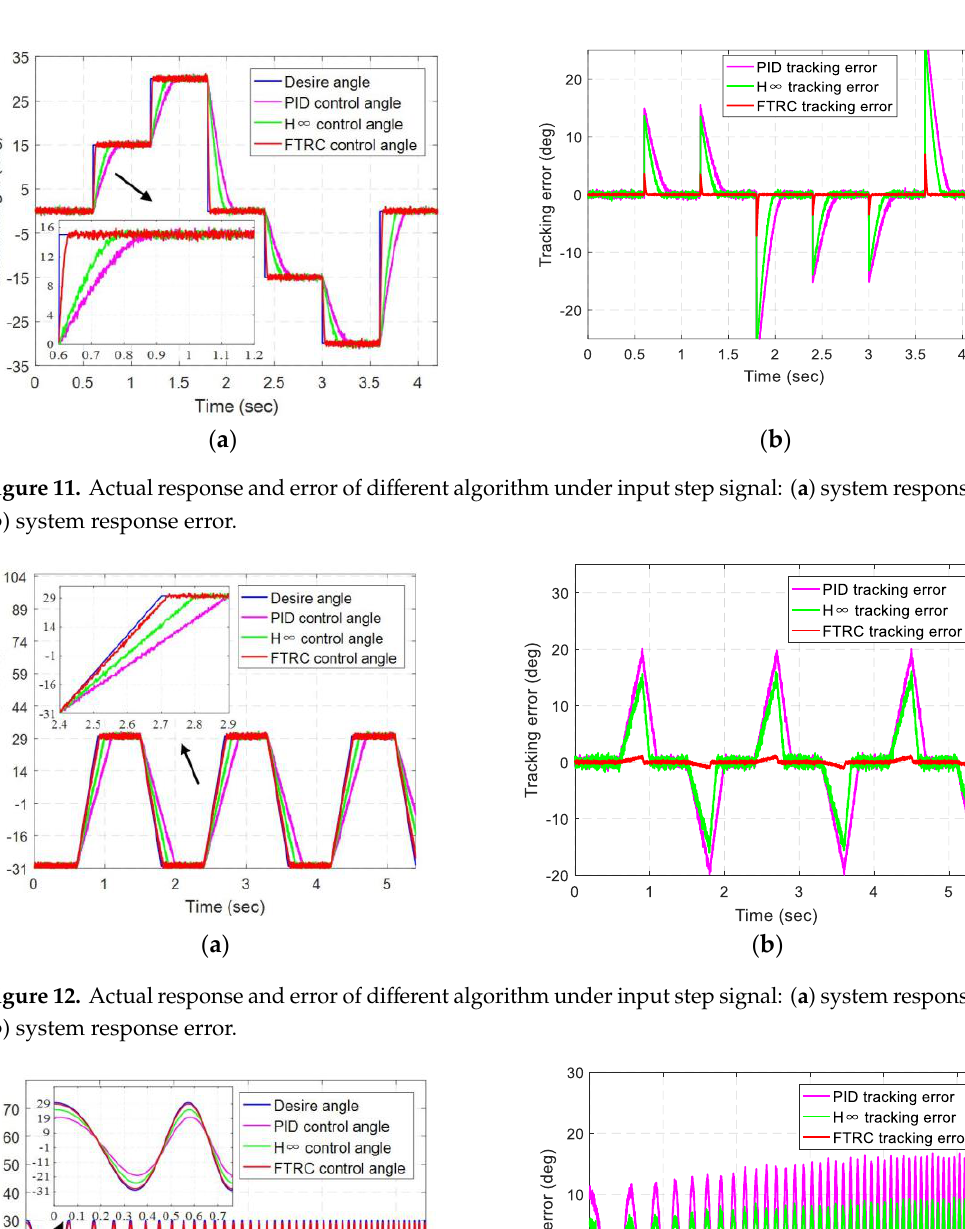
Figure 12. Actual response and error of different algorithm under input step signal: ( a ) system response; ( b ) system response error.